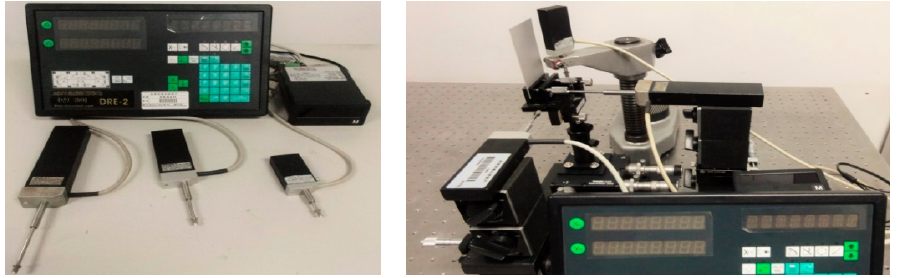
Figure 9. Three grating rulers.